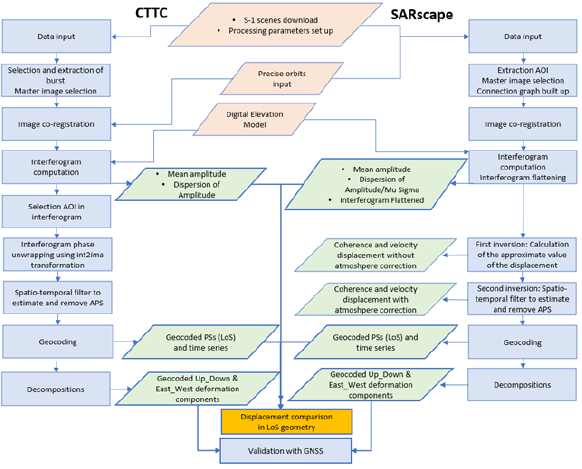
Figure 4. Flowchart of the